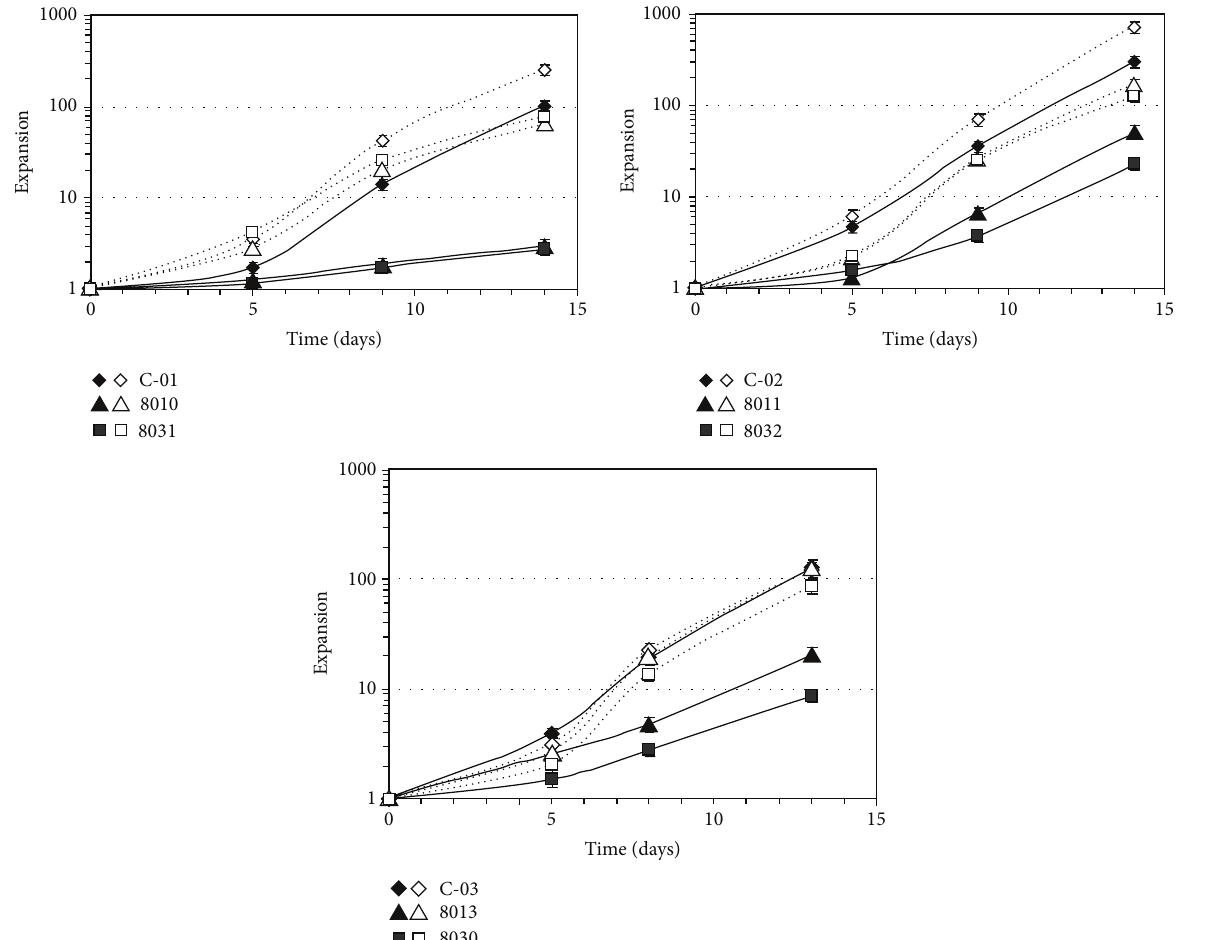
Figure 2: PPBL B cells proliferate following low CD154 interaction. Purified B cells isolated from samples obtained from healthy individuals (C-01, C-02, and C-03) and from patients with PPBL (8010, 8011, 8013, 8030, 8031, and 8032) were activated in vitro using a low level (open symbols; dashed line) or a high level (filled symbols; plain line) of CD154 interaction in the presence of cytokines, as indicated in